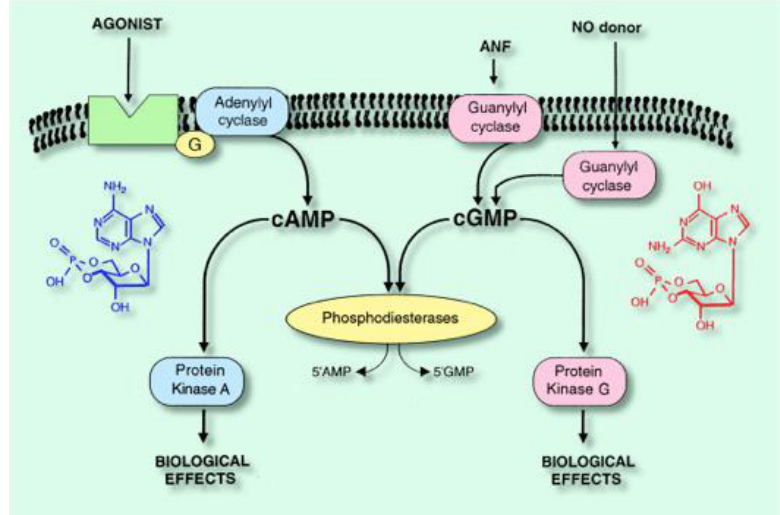
Figure 1. Intracellular signaling and cyclic nucleotide phosphodiesterases [2].